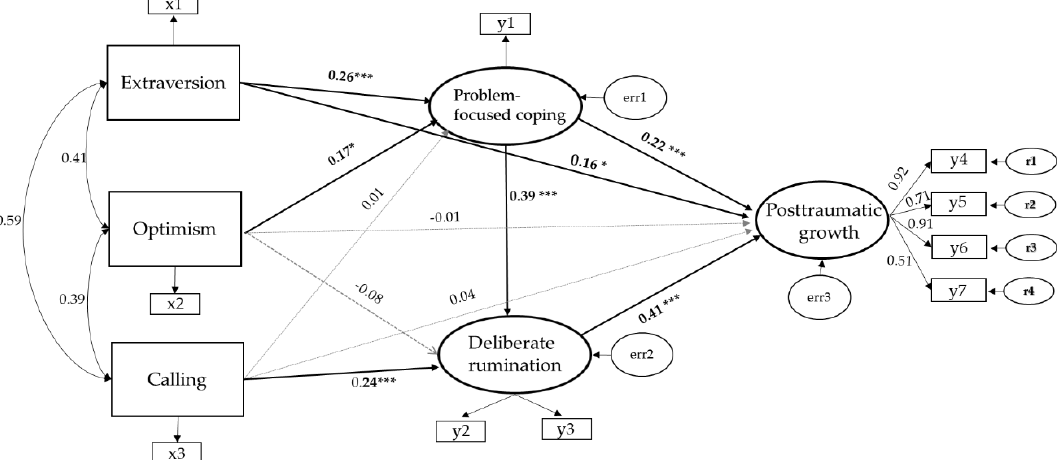
Figure 1. Final model with standardized path coefficients, where all variables are related to one another. All parameters are standardized and statistically significant. Note: *** p < 0.001, * p < 0.05 .